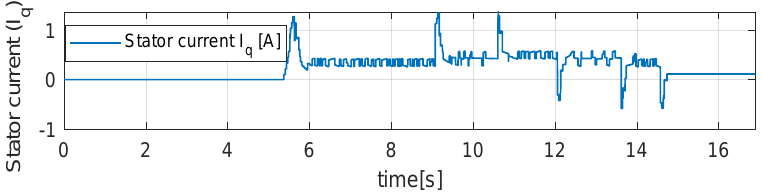
Figure 9. Stator quadrature current (experimental test II).